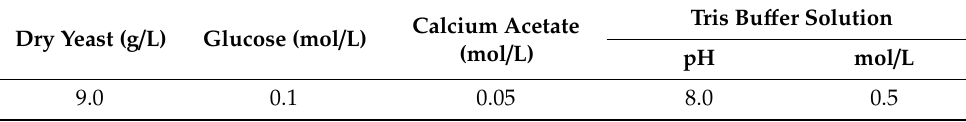
Table 3. The basic composition of yeast-based mixtures.